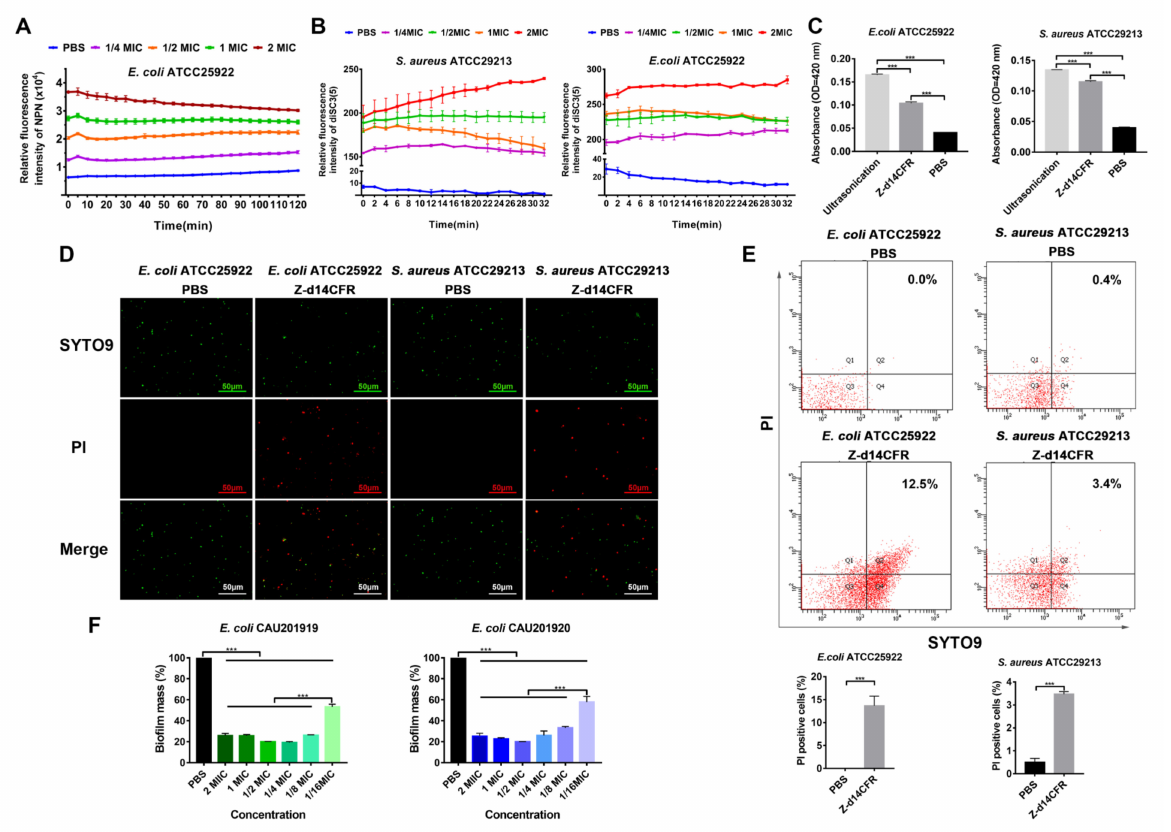
Figure 6. Antibacterial mechanism of Z-d14CFR. ( A ) Dynamic curves of NPN uptake in E. coli ATCC25922 after incubating with 2 MIC, 1 MIC, 1/2 MIC, 1/4 MIC Z-d14CFR, 10 mM PBS as the negative control. ( B ) Dynamic curves of DiSC 3 (5) release in E. coli ATCC25922 and S. aureus ATCC29213 after incubating with 2 MIC, 1 MIC, 1/2 MIC, 1/4 MIC Z-d14CFR, 10 mM PBS as the negative control. ( C ) Extracellular release of β -galactosidase in E. coli ATCC25922 and S. aureus ATCC29213 induced by 2 MIC Z-d14CFR, 10 mM PBS as the negative control, ultrasonication as the positive control. ( D ) SYTO9/PI staining of E. coli ATCC25922 and S. aureus ATCC29213 treated with 10 mM PBS or 2 MIC Z-d14CFR for 3 h under laser confocal microscope. ( E ) Flow cytometry of PI-positive cells treated with 10 mM PBS or 2 MIC Z-d14CFR for 3 h. ( F ) Biofilm formation